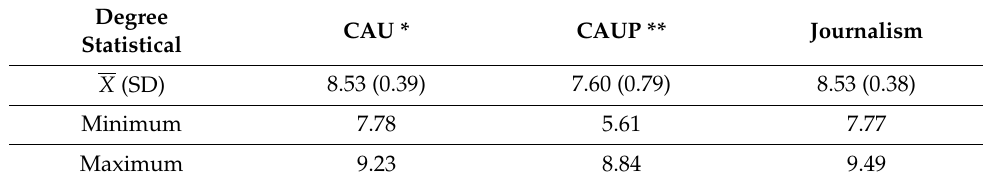
Table 2. Descriptions of the average grades obtained by degree